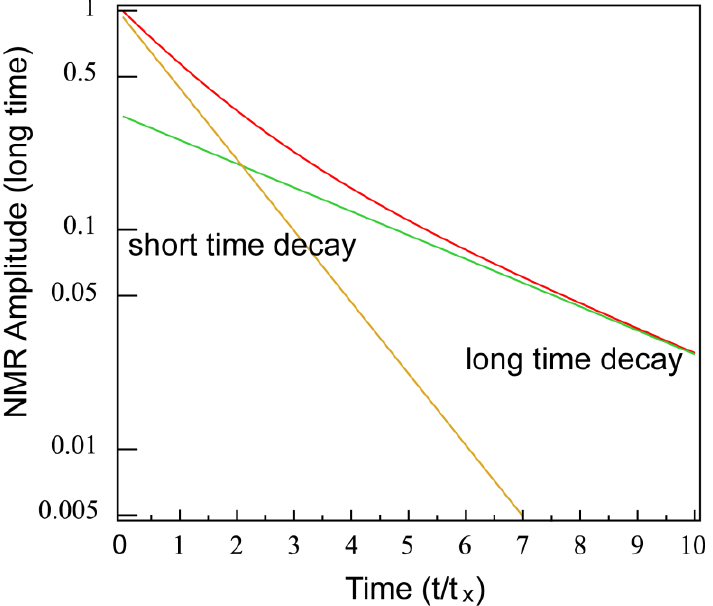
Figure A1. Schematic representation of the two decay rates for the three-bath system for RR  in Equation (A19). The short and long time decays are given 3  and 1   XBLAB  and 4.0  , by 1.33 X X